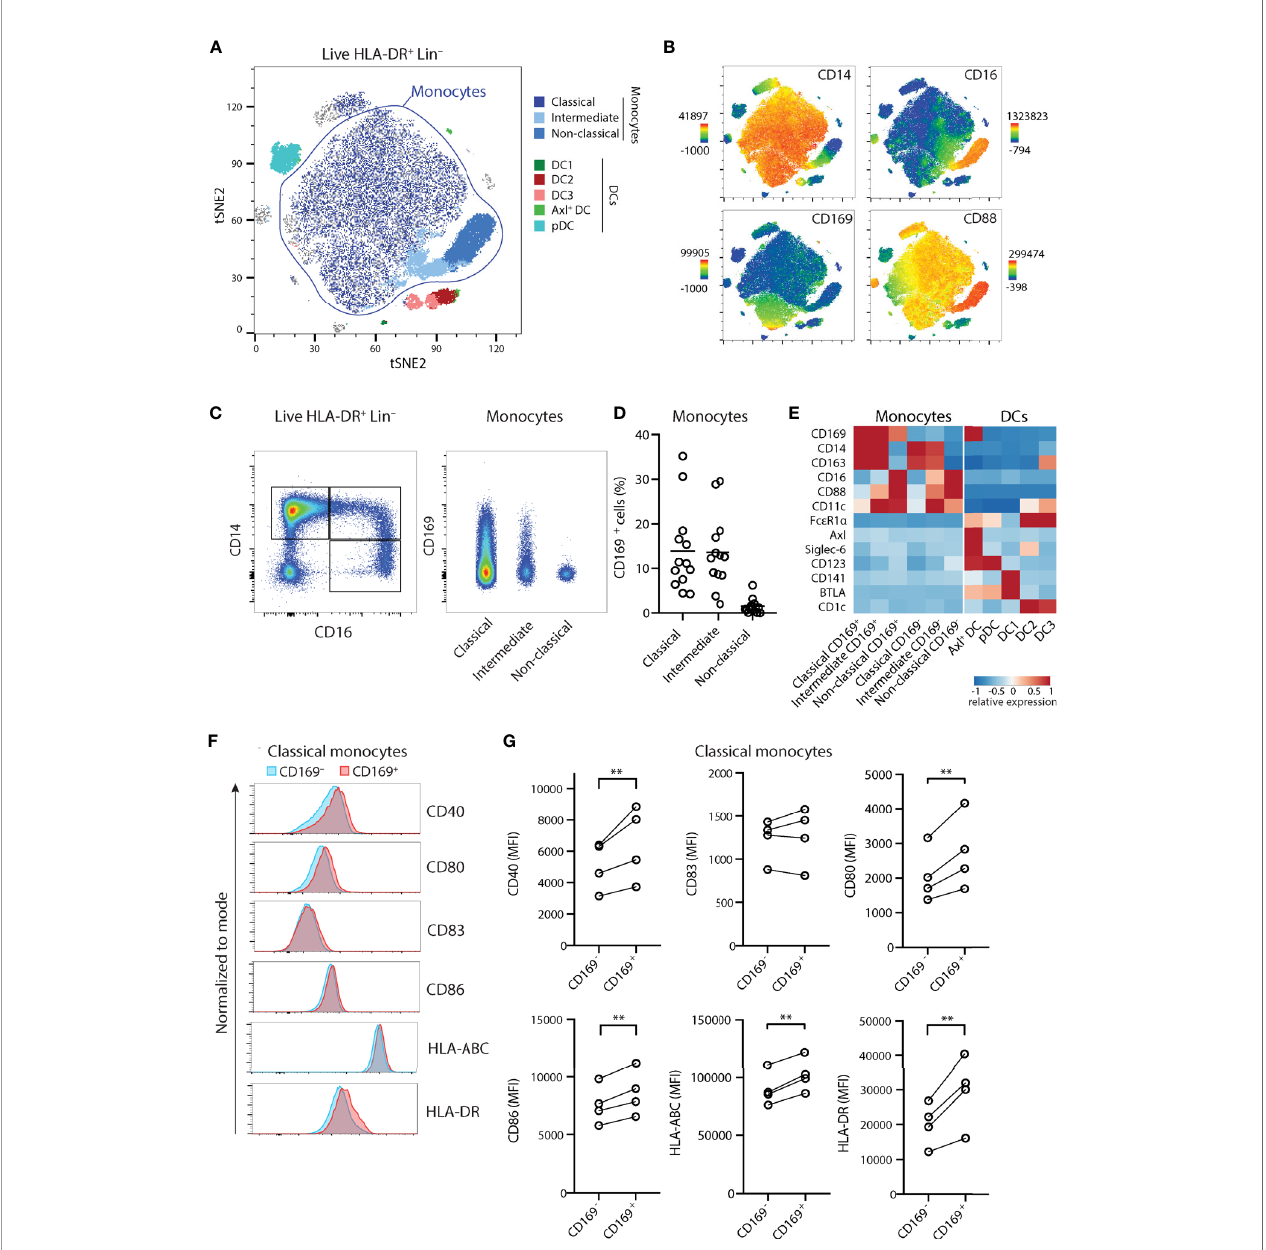
FIGURE 1 | CD14 + CD169 + monocytes display enhanced maturation status. (A) Unsupervised high dimensionality reduction analysis of circulating monocytes and dendritic cells (HLA-DR + CD3/CD19/CD56 – ) using CD14, CD16, CD88, CD163, HLA-DR, Fc ϵ R1 a , CD123, CD11c, CD1c, CD141, Axl, Siglec-6, BTLA, and CD169 using opt-SNE, and overlaid with conventional gating. (B) The expression of CD14, CD16, CD88, and CD169 on tSNE plots. (C) Gating strategy identi fi es classical (CD14 + CD16 - ), intermediate (CD14 + CD16 + ), or non-classical (CD14 - CD16 + ) monocytes, and CD169 + cells. (D) Percentage of CD169 + cells within monocytes subsets ( n = 13) in healthy donors. (E) Heatmaps comparing the relative expression of markers de fi ning monocytes and DC subsets. (F, G) Expression of co- stimulatory and HLA molecules are compared between CD169 + and CD169 - classical monocytes shown as (F) representative histograms and (G) quanti fi cation ( n = 4). Paired t-tests were used. **P <